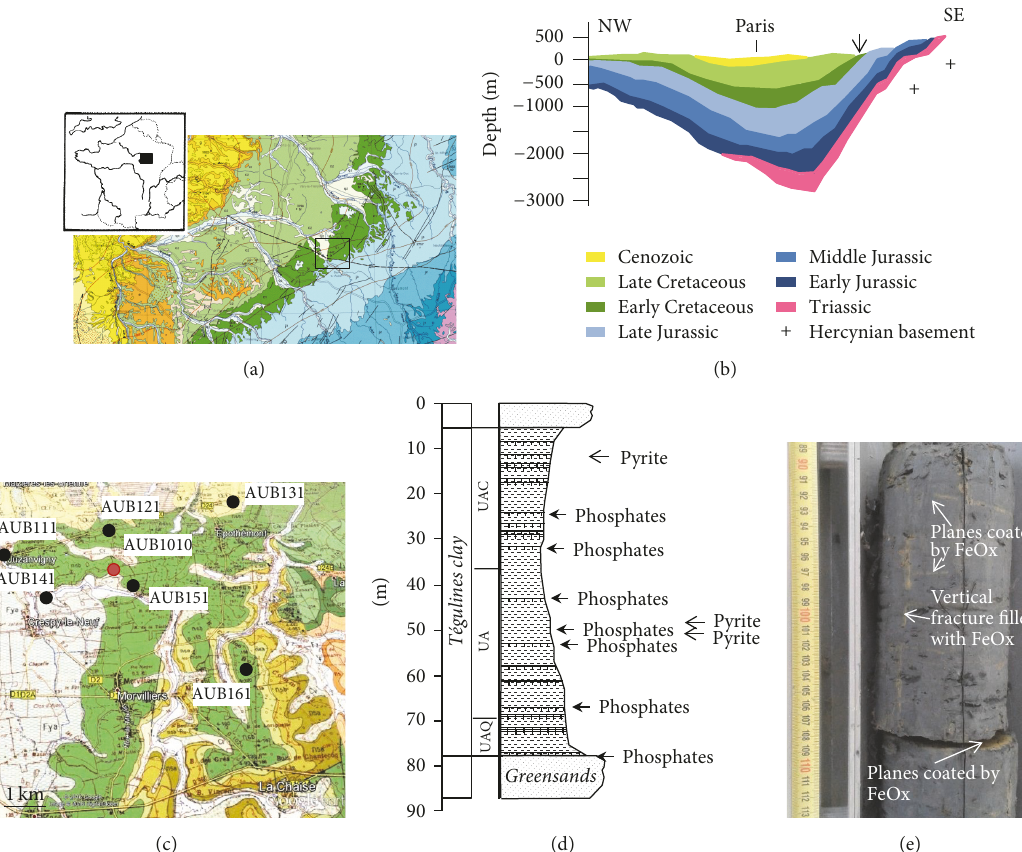
Figure 1: (a) Geological map of the eastern part of the Paris Basin showing the study area; (b) NW-SE schematic cross-section of the Paris Basin according to the Gonc¸alv`es et al. hydro-thermo-mechanical model [18]. The Gault clay is a part of the dark green area. (c) Geological map of the area studied and location of the boreholes. (d) Schema of the lithostratigraphic sequence of the Gault clay in the area of Brienne-le- Chˆateau based on the boreholes AUB111 and AUB121 for which the thickness of the clay is largest. (e) Vertical fracture filled with Fe hydroxides (FeOx) crosscutting core sample AUB1010-9.25